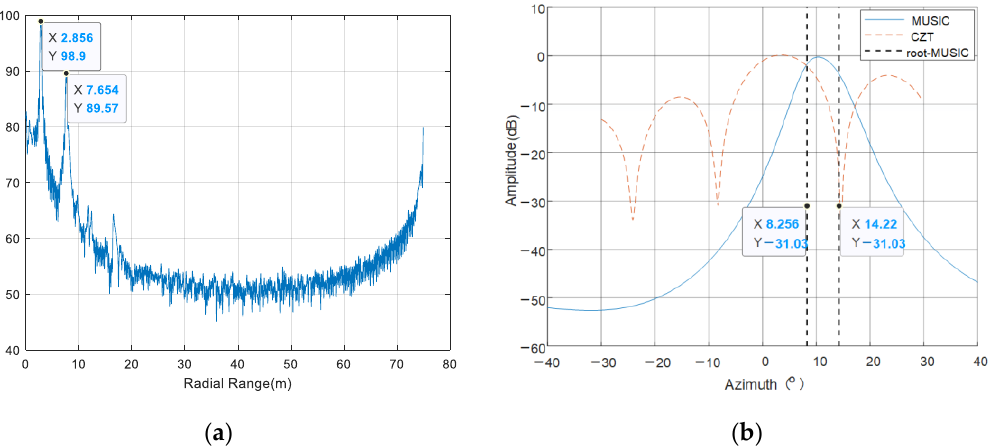
Figure 16. One-dimensional image and DOA results of the second experiment. ( a ) High resolution one-dimensional radar image. The first peak is the responses of two trihedral reflectors separated by 0.7 m in azimuth; ( b ) the angle between the two trihedral reflectors is smaller than the angular resolution, root-MUSIC can discriminate between them, but MUSIC and CZT fail.